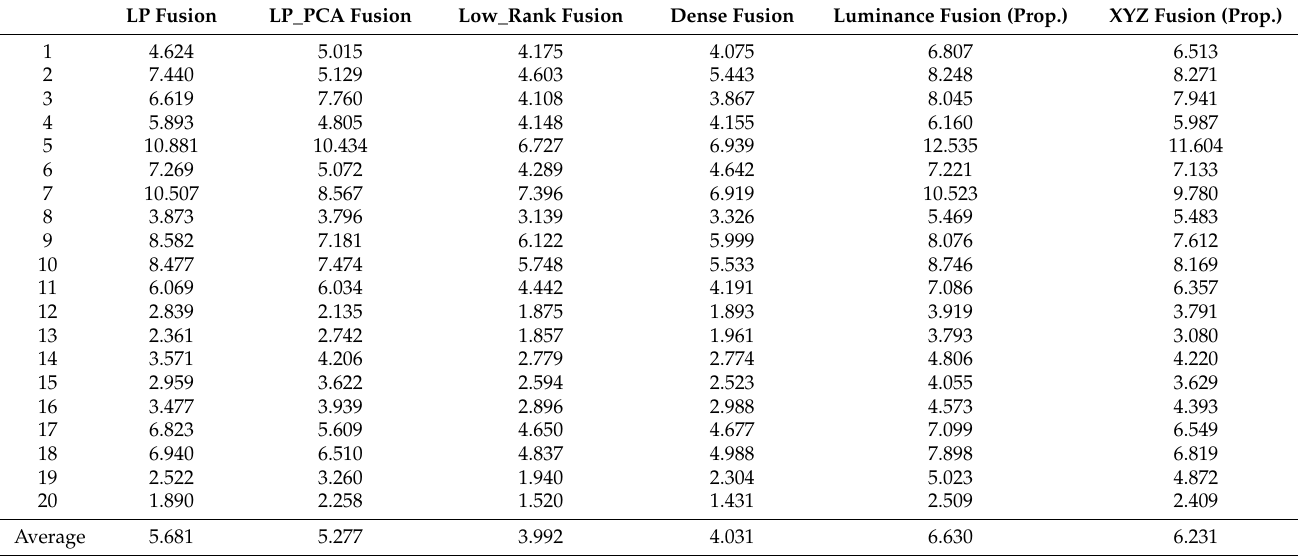
Table 10. Comparison of the Average gradient metrics.